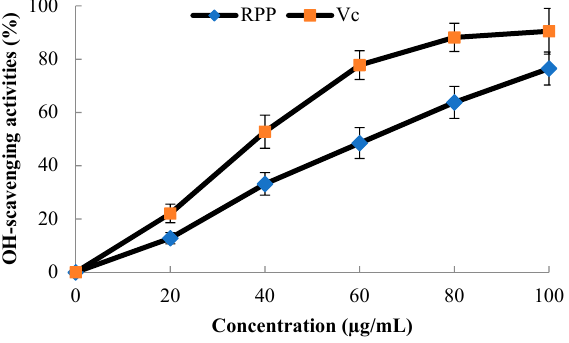
Figure 3. Hydroxyl radical (OH · )-scavenging activity of RPP with positive control of vitamin C (Vc). Values represent the mean ± standard error of three